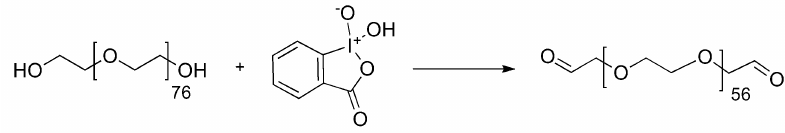
Figure 3. Synthesis scheme of the poly(ethylene glycol) dialdehdye (PEG-(CHO) 2 ) macromonomer. Preparation of bis(2-amido-lysine)-poly(ethylene glycol) (PEG-(Lys) 2 ) macromonomer: According to literature procedure